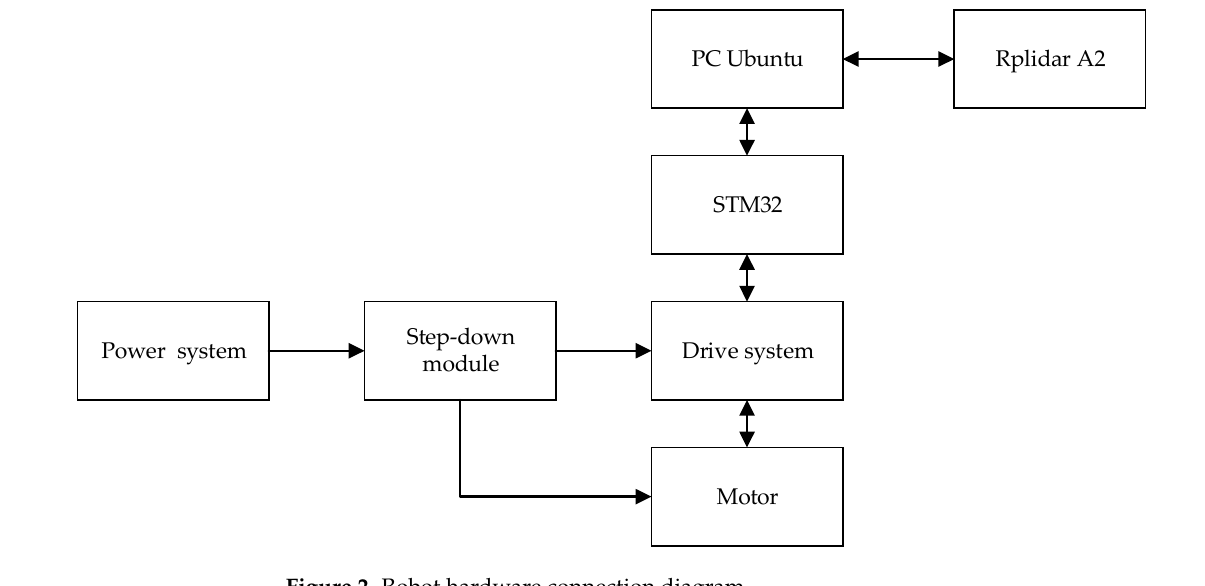
Figure 2. Robot hardware connection diagram.